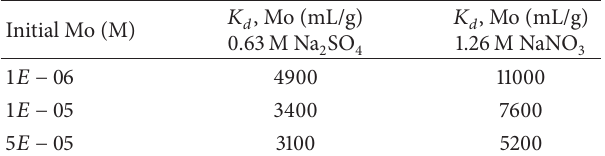
Table 1: Distribution ratios for Mo in the presence of sodium sulfate and sodium nitrate solutions.